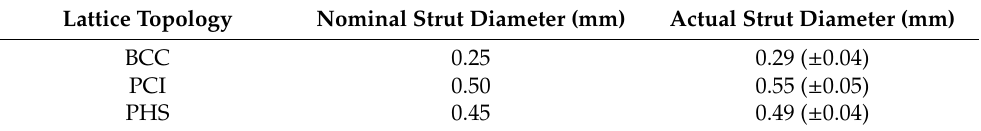
Table 2. Dimensional assessment of designed strut diameter and actual (mean ± standard